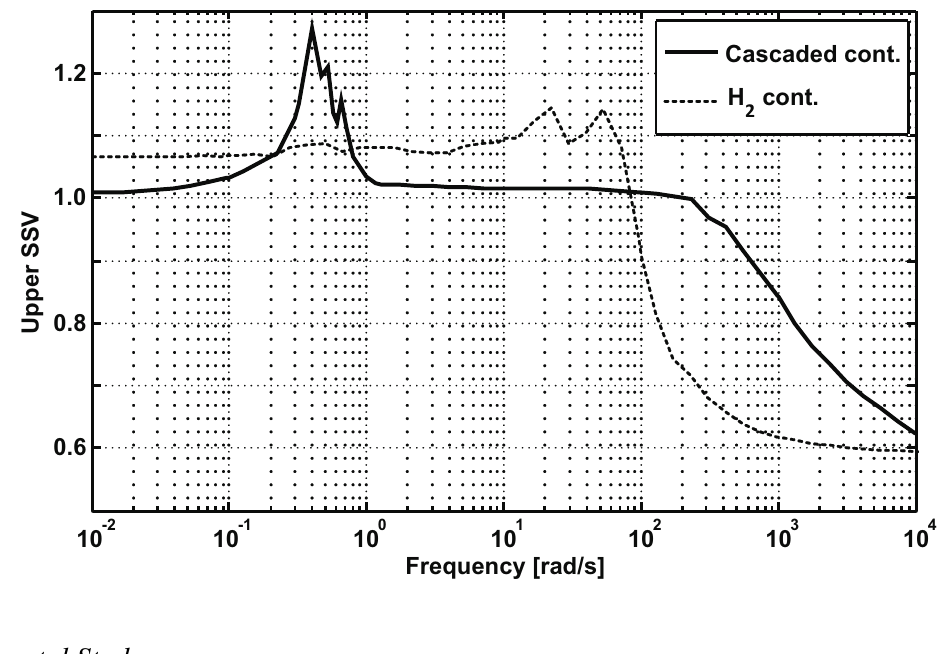
Figure 7. Upper structured singular value (SSV) of the classical cascaded and augmented torque H 2